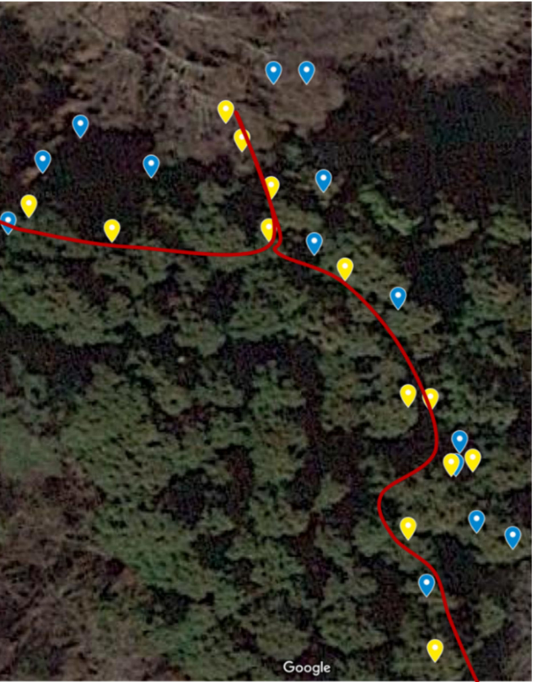
Figure 11. Estimated position in Mt. Kentoku (red line: actual route, blue dot: GPS record, yellow dot: estimated